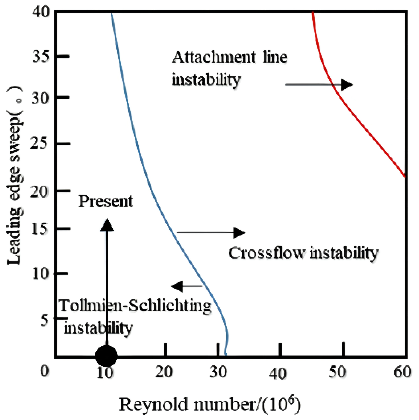
Figure 8. Relationship between instability types and sweep angle of leading edge and Re.